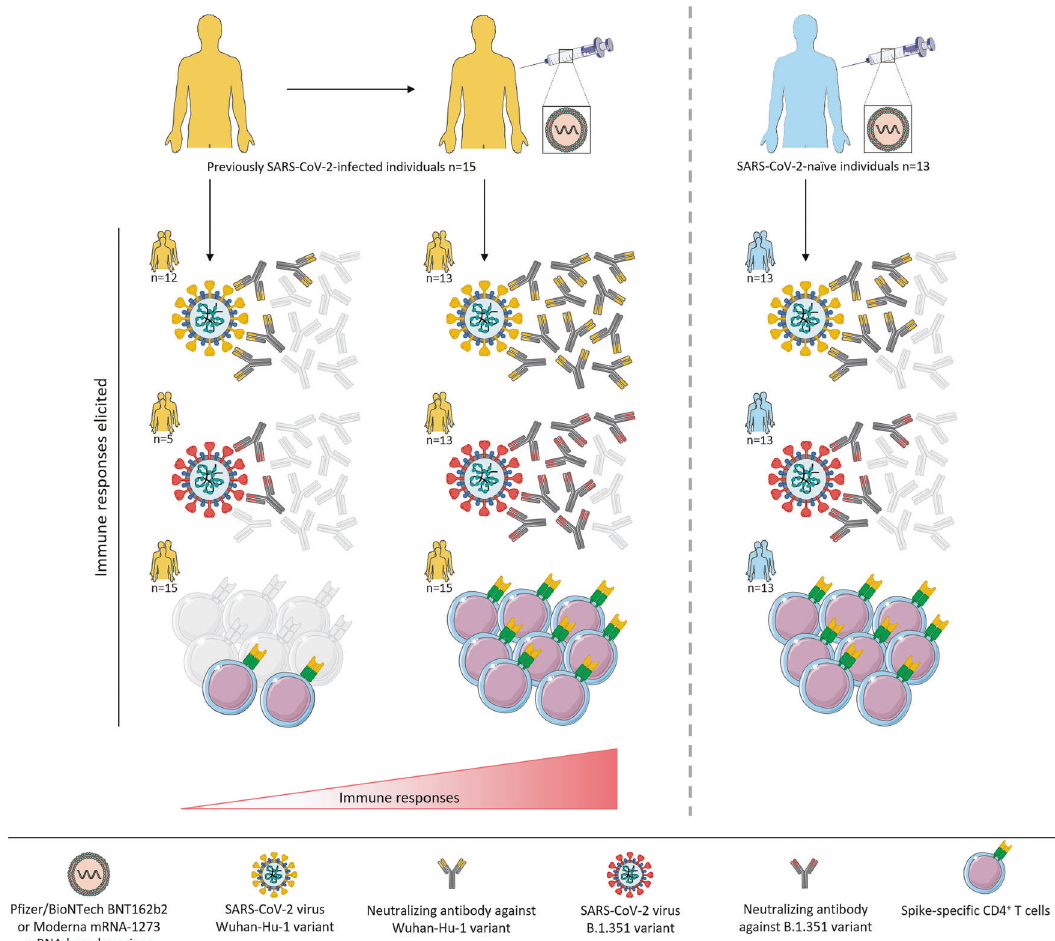
Fig. 1 Immune responses to SARS-CoV-2 variants are elicited following mRNA vaccination and are further increased in previously SARS-CoV-2- infected and recovered individuals after vaccination. Neutralizing antibody titers against Wuhan-Hu-1 and B.1.351 along with the frequency of spike-speci fi c CD4 + T cells are greatly enhanced in previously SARS-CoV-2-infected individuals subsequent to mRNA vaccination. Neutralizing antibody titers against both the Wuhan-Hu-1 vaccine antigen and the B.1.351 variant are higher than in SARS-CoV-2-naive individuals who received either P fi zer/BioNTech BNT16b2 or Moderna mRNA-1273 vaccine, while an equally high level of spike-speci fi c CD4 + T cells is detected in both vaccinated groups. Overall, neutralizing antibodies against B.1.351 variants are present but at lower titers than against Wuhan-Hu-1 variants in all groups of individuals regardless of